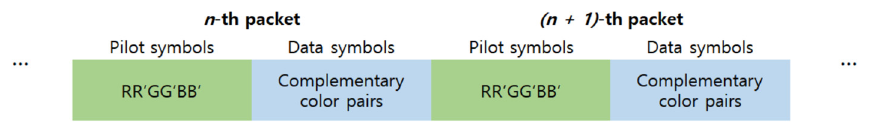
Figure 3. Transmit packet structure of CCB-OCC.